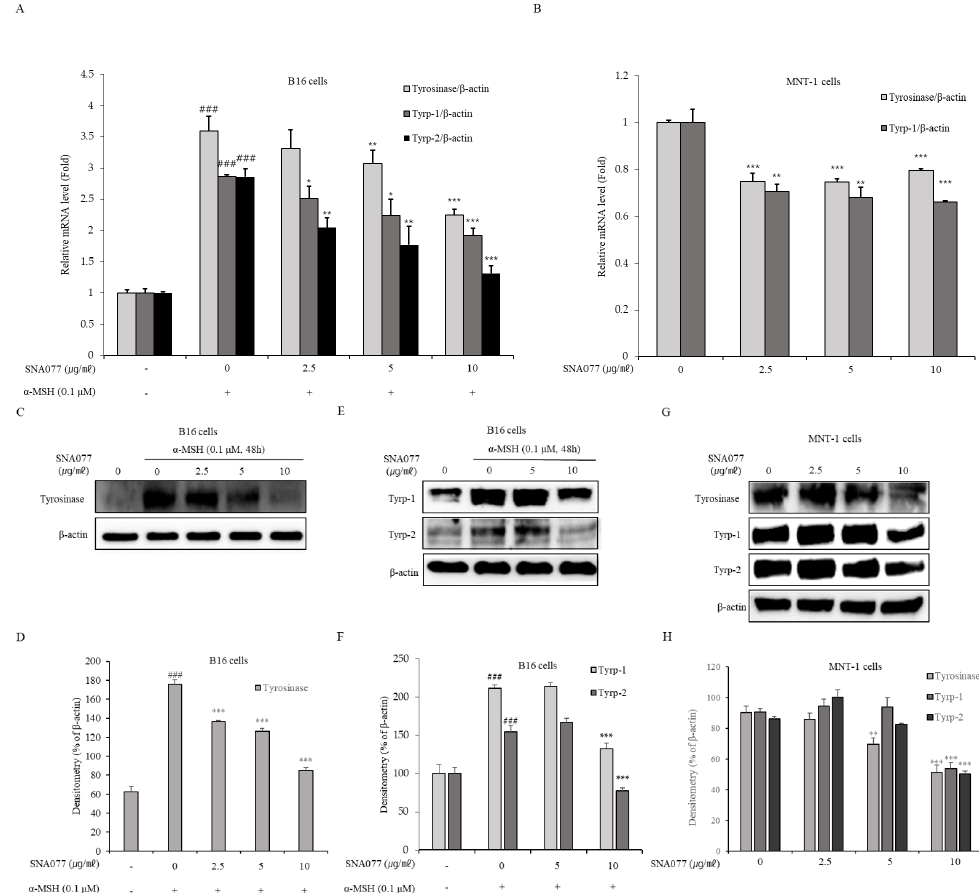
Figure 3. Inhibitory effect of SNA077 on the expression of melanogenic enzymes. ( A , B ) mRNA levels of melanogenic enzyme-encoding genes were determined by real-time qPCR analysis in B16 cells ( A ) and MNT-1 cells ( B ). Cells were treated with SNA077 for 24 h. The mRNA levels of the genes encoding tyrosinase, Tyrp-1, and Tyrp-2 were normalized to that of β -actin. ( C , E , G ) The protein levels of melanogenic enzymes were determined by Western blot analysis in B16 cells ( C , E ) and MNT-1 cells ( G ). Cells were treated with SNA077 for 72 h. Equal amounts of proteins were resolved by 10% SDS-PAGE and detected using specific antibodies. β -Actin was detected as a loading control. ( D , F , H ) Protein bands were densitometrically quantified and analyzed using ImageJ software. Results for B16 cells ( D , F ) and MNT-1 cells ( H ) are presented as means ± SD, expressed as a percentage relative to controls (** p < 0.01, *** p < 0.001 vs. control group; ### p < 0.001 vs. the α -MSH-untreated control group).